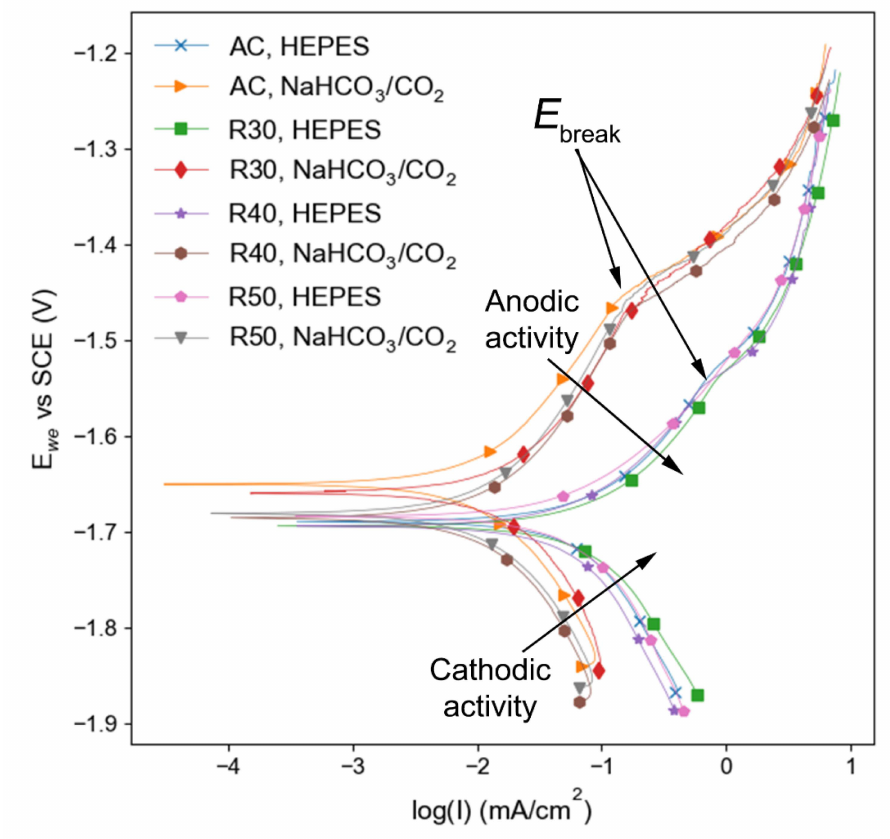
Figure 9. PDP curves of Mg-1Zn samples immersed in EBSS buffered with either HEPES or NaHCO 3 /CO 2 . Table 4. Electrochemical data from polarisation tests and 15 d mass loss corrosion rates ( CR m ) from immersion